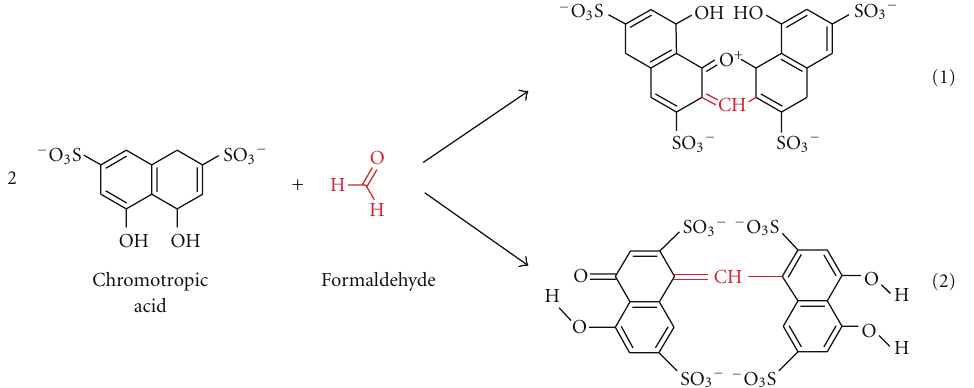
Figure 1: Hypothetical reaction products of the chromotropic acid-formaldehyde reaction [7]. The monocationic dibenzoxanthylium structure (1) is the more likely product (see text).